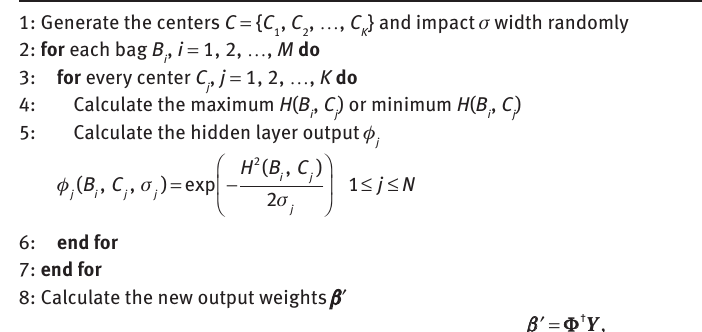
Algorithm 1: MI-ELM algorithm.